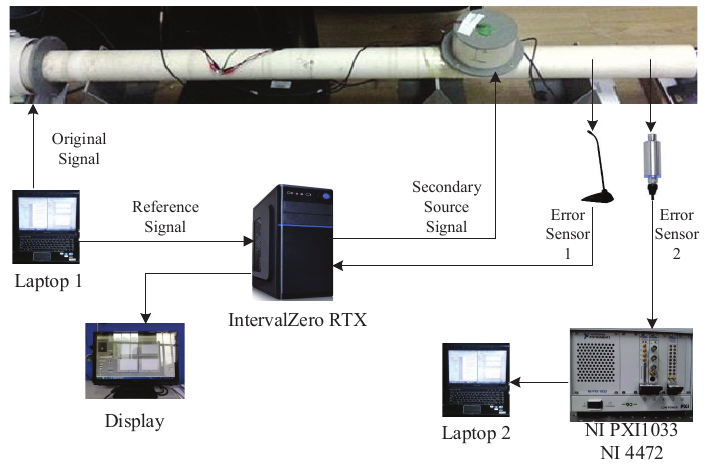
Figure 9. Diagram of the real-time experiment.